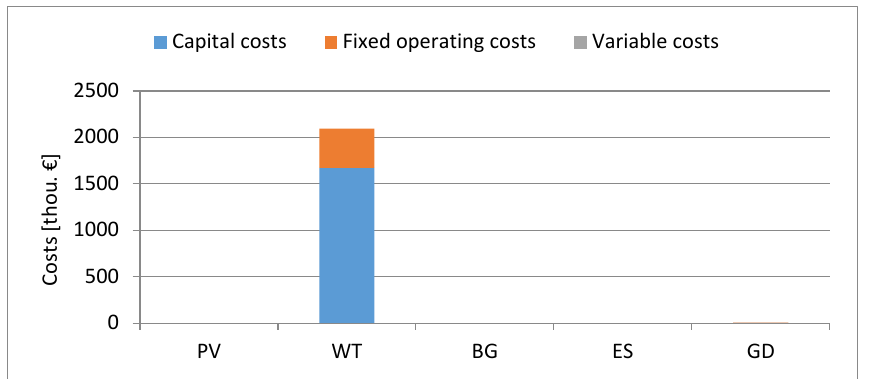
Figure 6. The cost structure for scenario “5”.